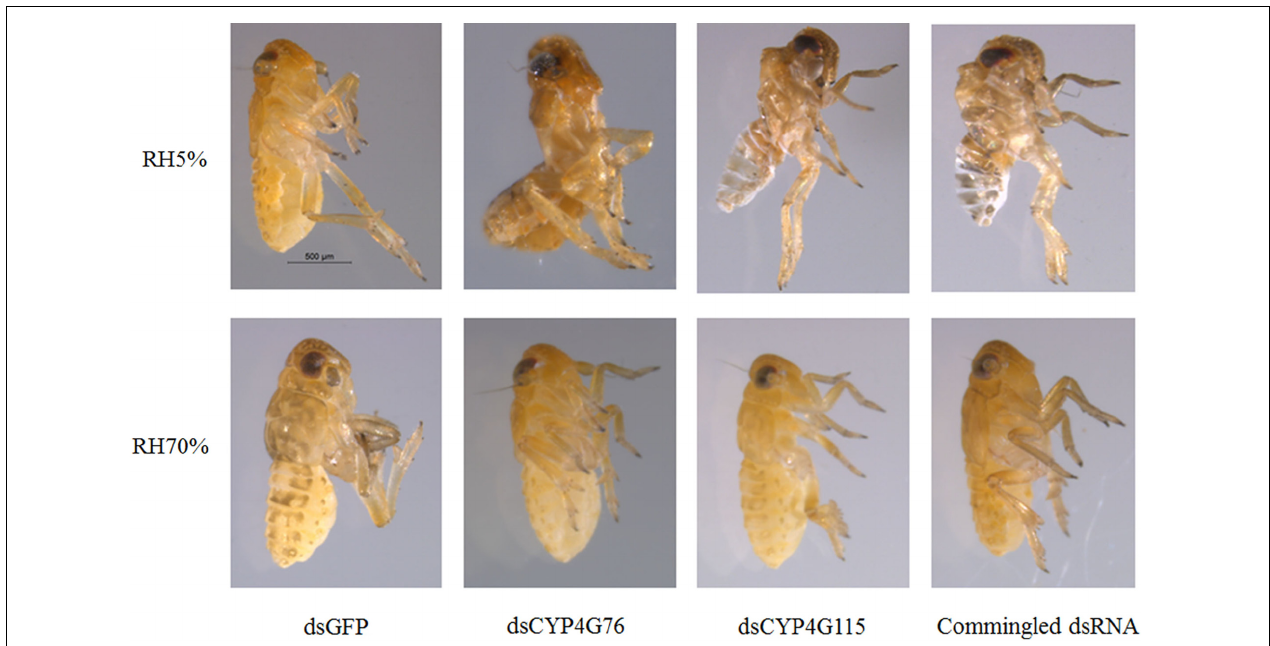
FIGURE 7 | Effect of RNAi suppression of CYP4G76 and CYP4G115 on the phenotype of Nilaparvata lugens nymph following desiccation treatment (RH < 5% for 24 h). Commingled dsRNA contained CYP4G76 and CYP4G115